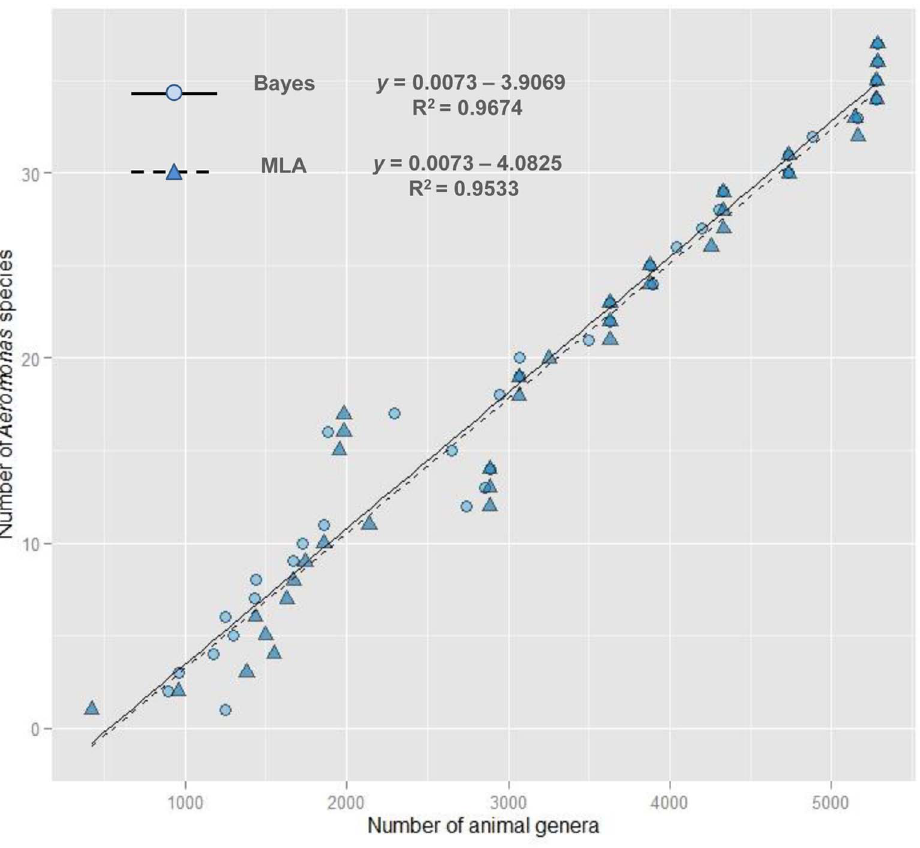
Figure 10. Regression plot between the number of animal genera and the number of Aeromonas species. The plot shows the number of animal genera obtained from Sepkoski’s data and the number of Aeromonas species in the last 250 Ma, applying both the Bayesian and the MLA approaches.